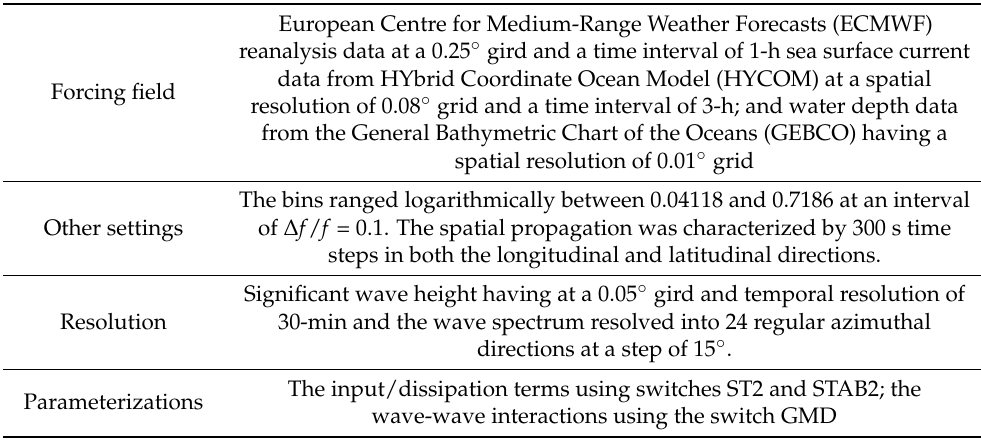
Table A1. Settings of the WAVEWATCH-III model (WW3) (version